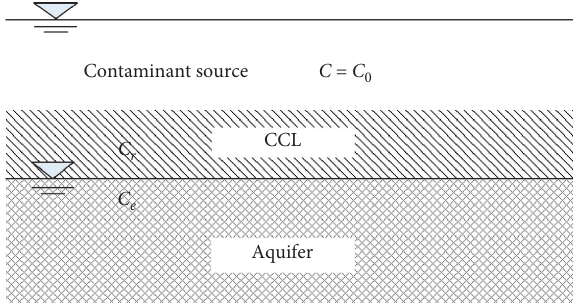
Figure 1: Calculation model. Table 1: Analyses